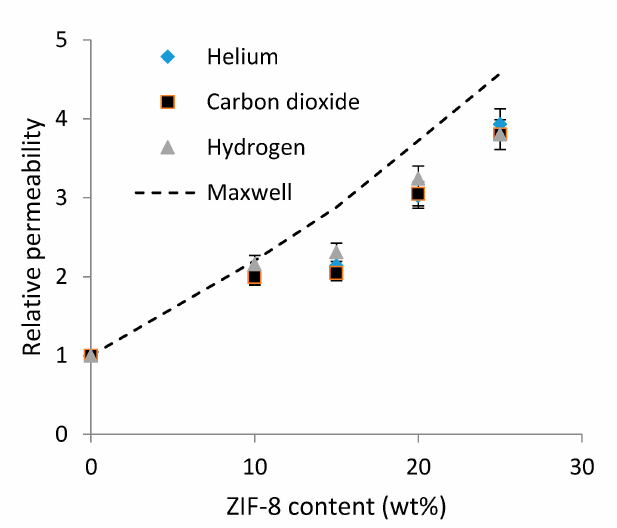
Figure 8. Relative permeability variation as a function of ZIF-8 content for the three studied gases: comparison with theoretical data obtained from Maxwell